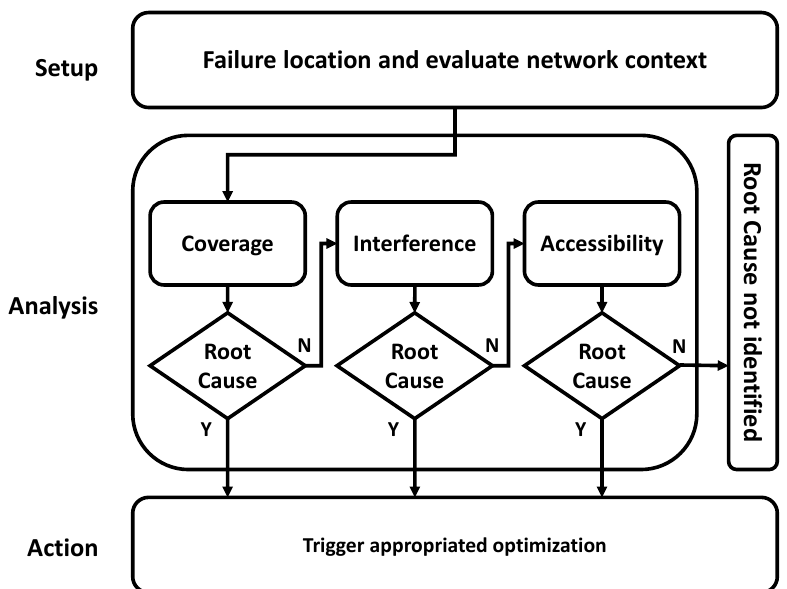
Figure 9. The RCA workflow for the troubleshooting case study.